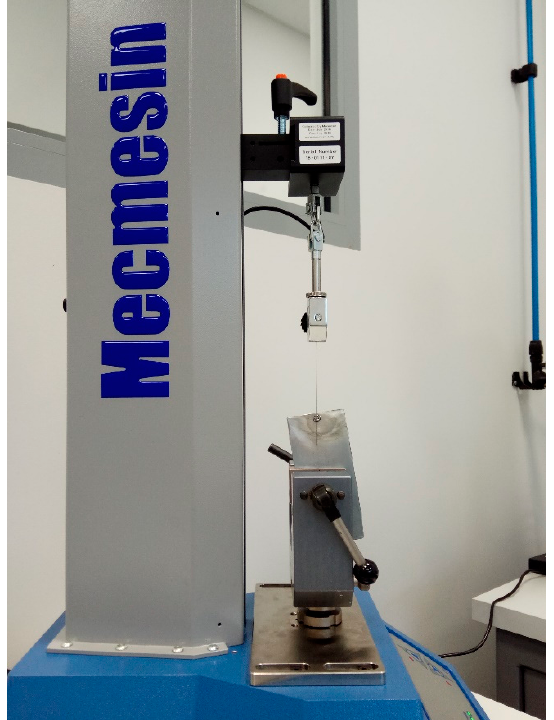
Figure 1. A model mounted in the base handle of the force testing machine. Afterward, 10 mm of the upper end of the wire was fixed to the special tension-loading cell of the tensile measuring machine with a range of up to 10 N loadcell capacity and full-scale accuracy of ±0.1%. Subsequently, the wire was pulled through at a crosshead speed of 10 mm/min for a distance of 20 mm. The machine was recording 1000 measurements of FF per second. The kinetic FF was measured by averaging the FFs exerted during the 120 s long-lasting wire movement. Recorded measurements of dynamic FF for each of